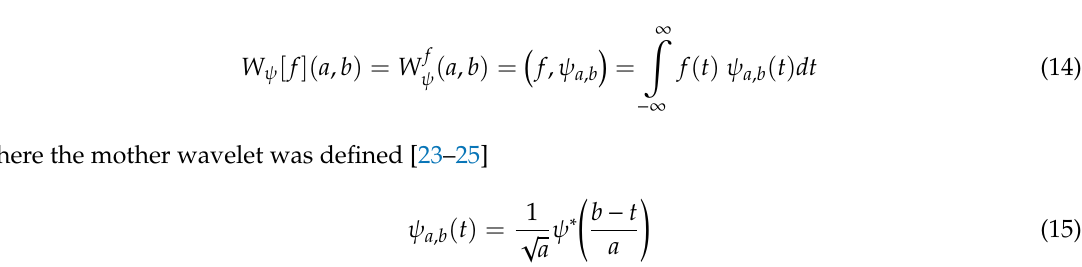
Figure 5. Wavelets for complex multi-scale analyses, in terms of modulus-phase components and real-imaginary parts respectively: ( a ) complex Gaussian wavelet of order 8; ( b ) complex Morlet wavelet; ( c ) complex frequency B-Spline wavelet; and ( d ) complex Shannon wavelet.